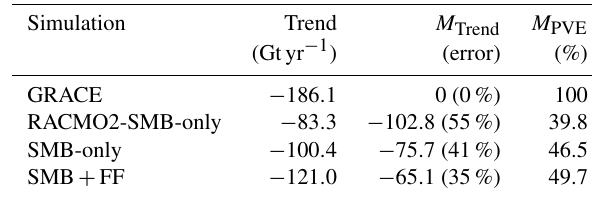
Table 3. Observed and modeled mass trend and scalar metrics M Trend and M PVE calculated for the RACMO2-SMB-only, SMB- only, and SMB + FF models from 2003 to